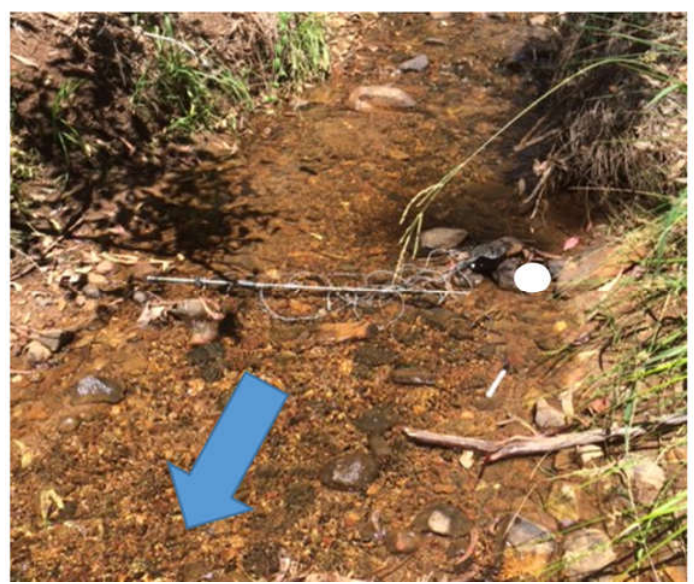
Figure 5. Photograph of measured channel section for Neerigen Brook Reach 2. Arrow pointing downstream. (picture K. Smettem)